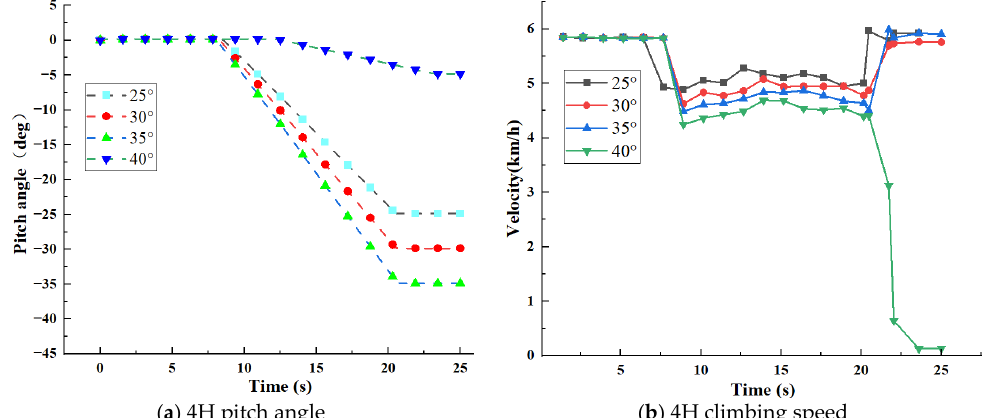
Figure 6. Results of the 4H climbing test.